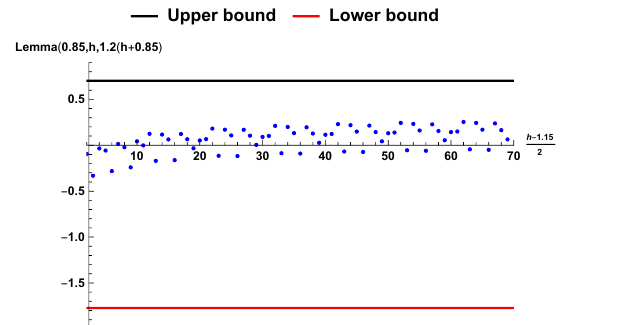
(cid:20) (cid:18) (cid:19)(cid:21) q 1 c (cid:22) h Q h; (cid:22) (cid:12) = (cid:25) (cid:0) 2 (cid:14) 6